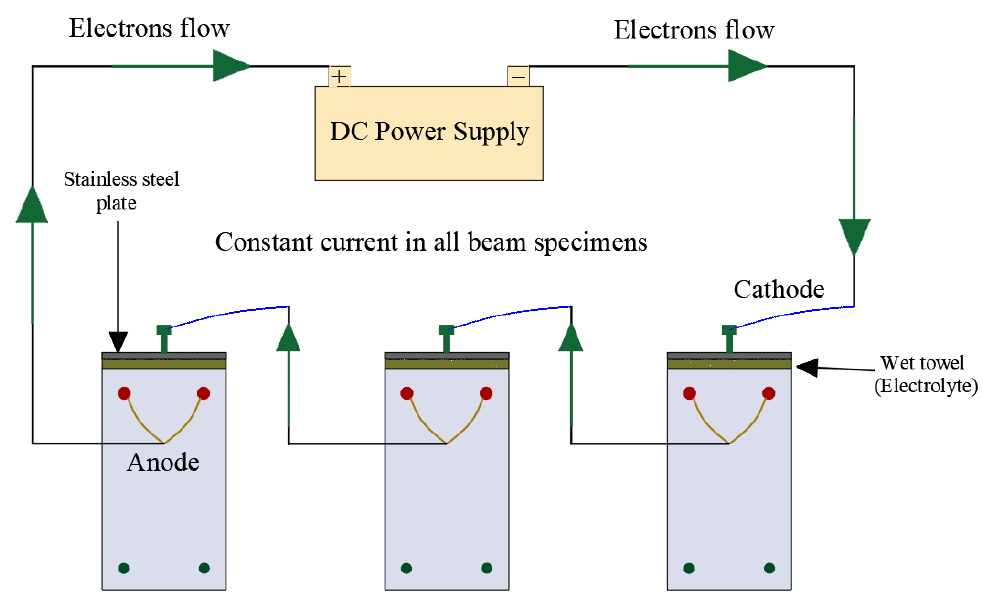
Figure 2. Schematic diagram showing the RC beam specimens connected to the proposed setup.